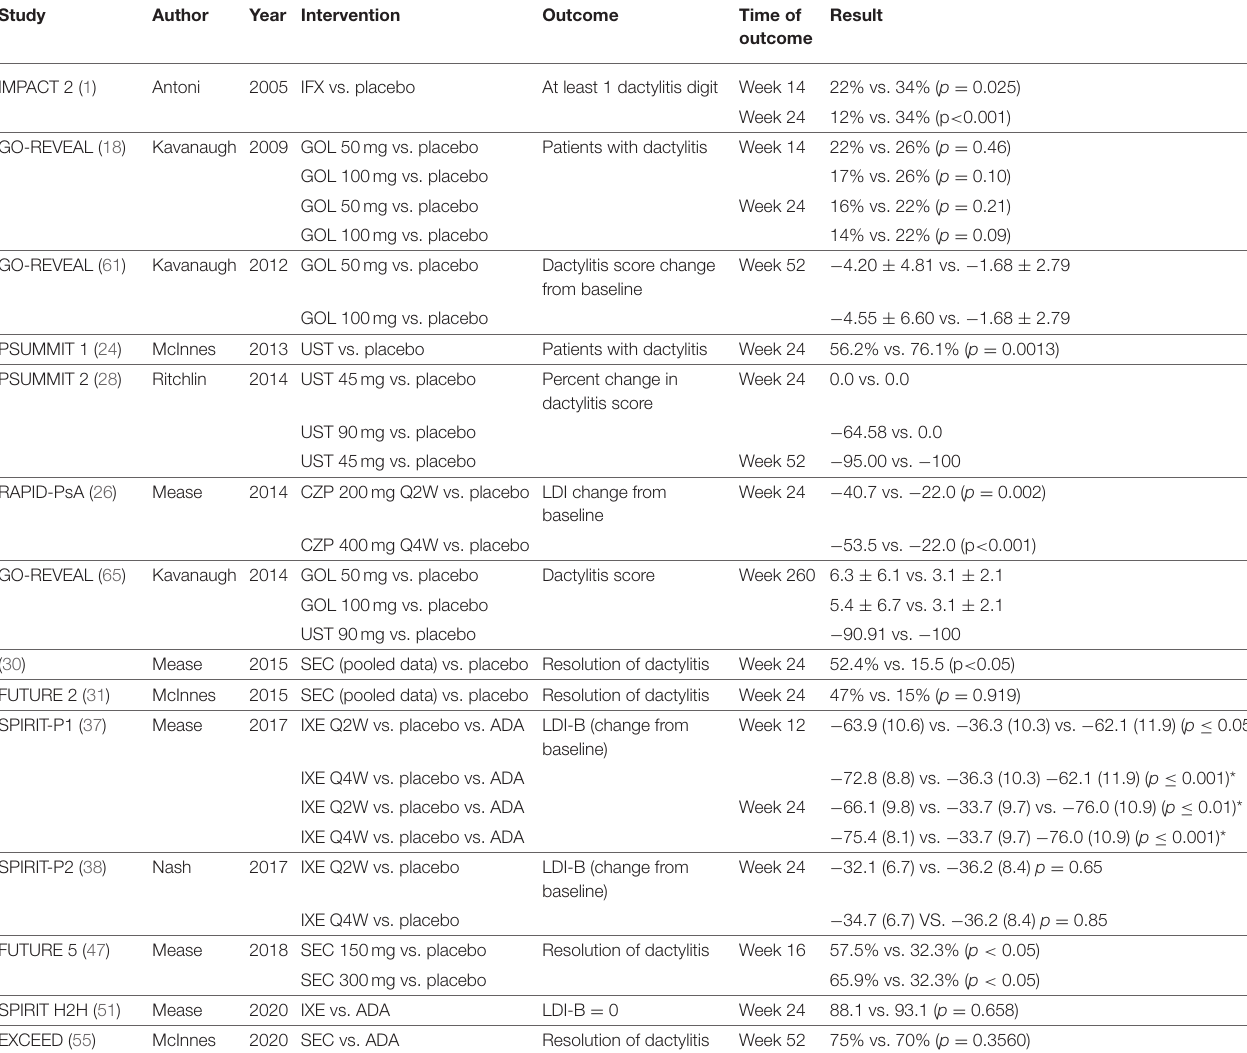
TABLE 6 | Dactylitis assessment in patients with psoriatic arthritis.